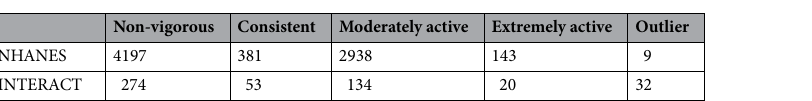
Table 2. Number of participants with each activity intensity profile for both INTERACT and